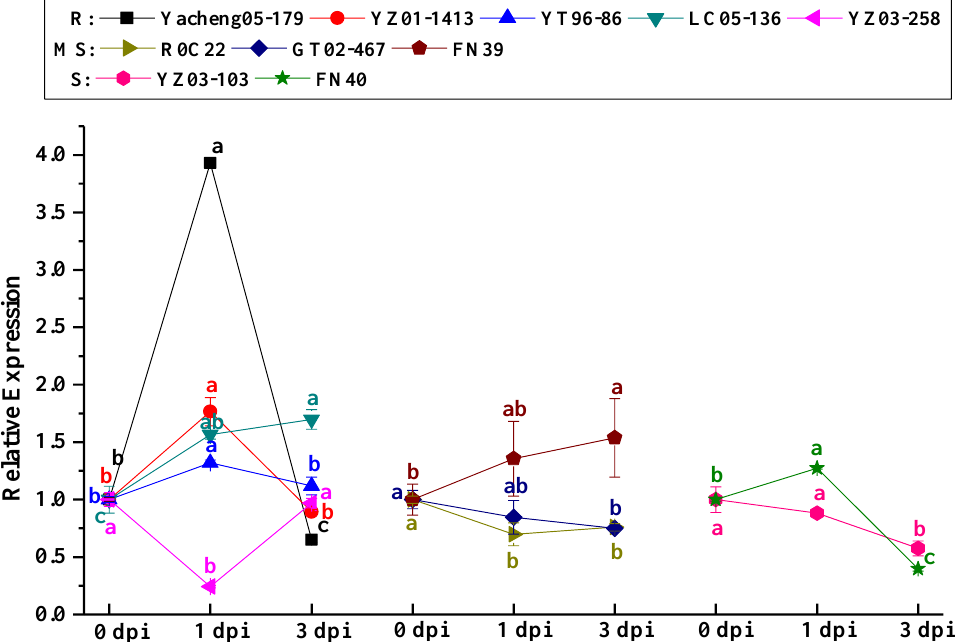
Figure 6. qRT-PCR analysis of the ScCAT2 expression in 10 different sugarcane genotypes after inoculation with Sporisorium scitamineum . The data were normalized to the expression level of the glyceraldehyde-3-phosphate dehydrogenase ( GAPDH ) gene. All data points (normalized to the control) were expressed as means ± standard error ( n = 3). Different lowercase letters indicated a significant difference ( p < 0.05) compared to the control, as determined with Duncan’s test. Yacheng05-179, YZ01-1413, YT96-86, LC05-136, and YZ03-258 were smut-resistant cultivars (R). ROC22, GT02-467, and FN39 were smut-medium-susceptibility cultivars (MS). YZ03-103 and FN40 were smut-susceptible cultivars (S). dpi, days post-inoculation.